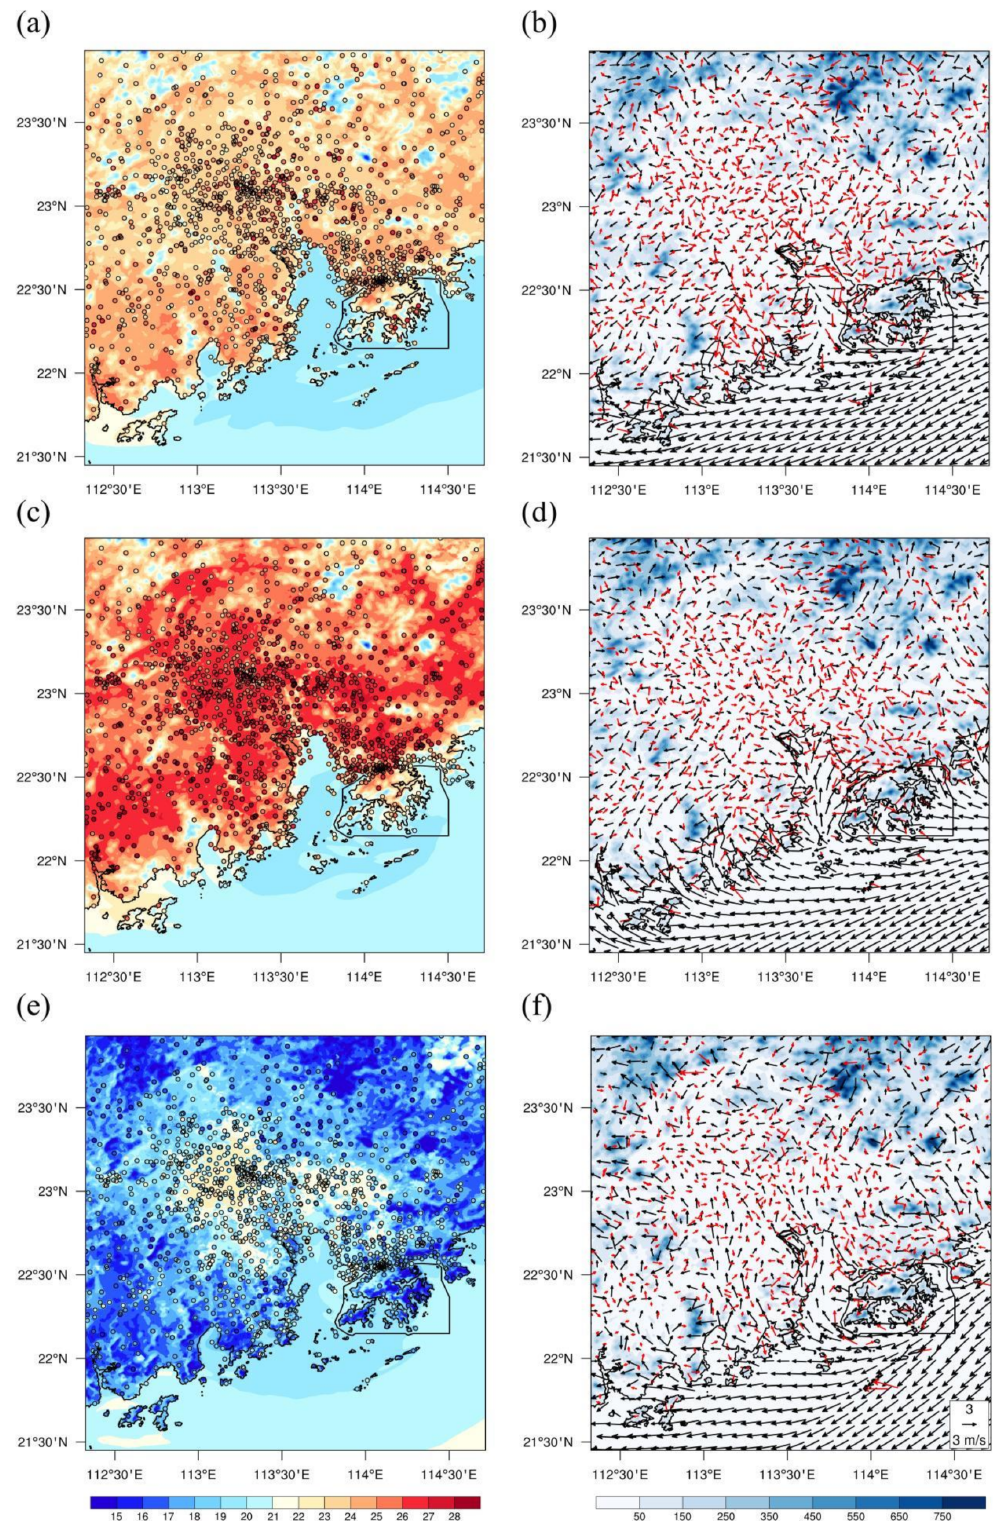
Figure 2. Simulated (the shaded) and observed (filled dots) 2 m temperature (( a , c , e ) unit: ◦ C); Simulated (black vector) and observed (red vector) 10 m wind field (( b , d , f ) unit: m/s) superimposed on topographic height (blue shade); The times are 1200 LST ( a , b ), 1600 LST ( c , d ), and 2200 LST ( e , f ) on 27 December 2020,